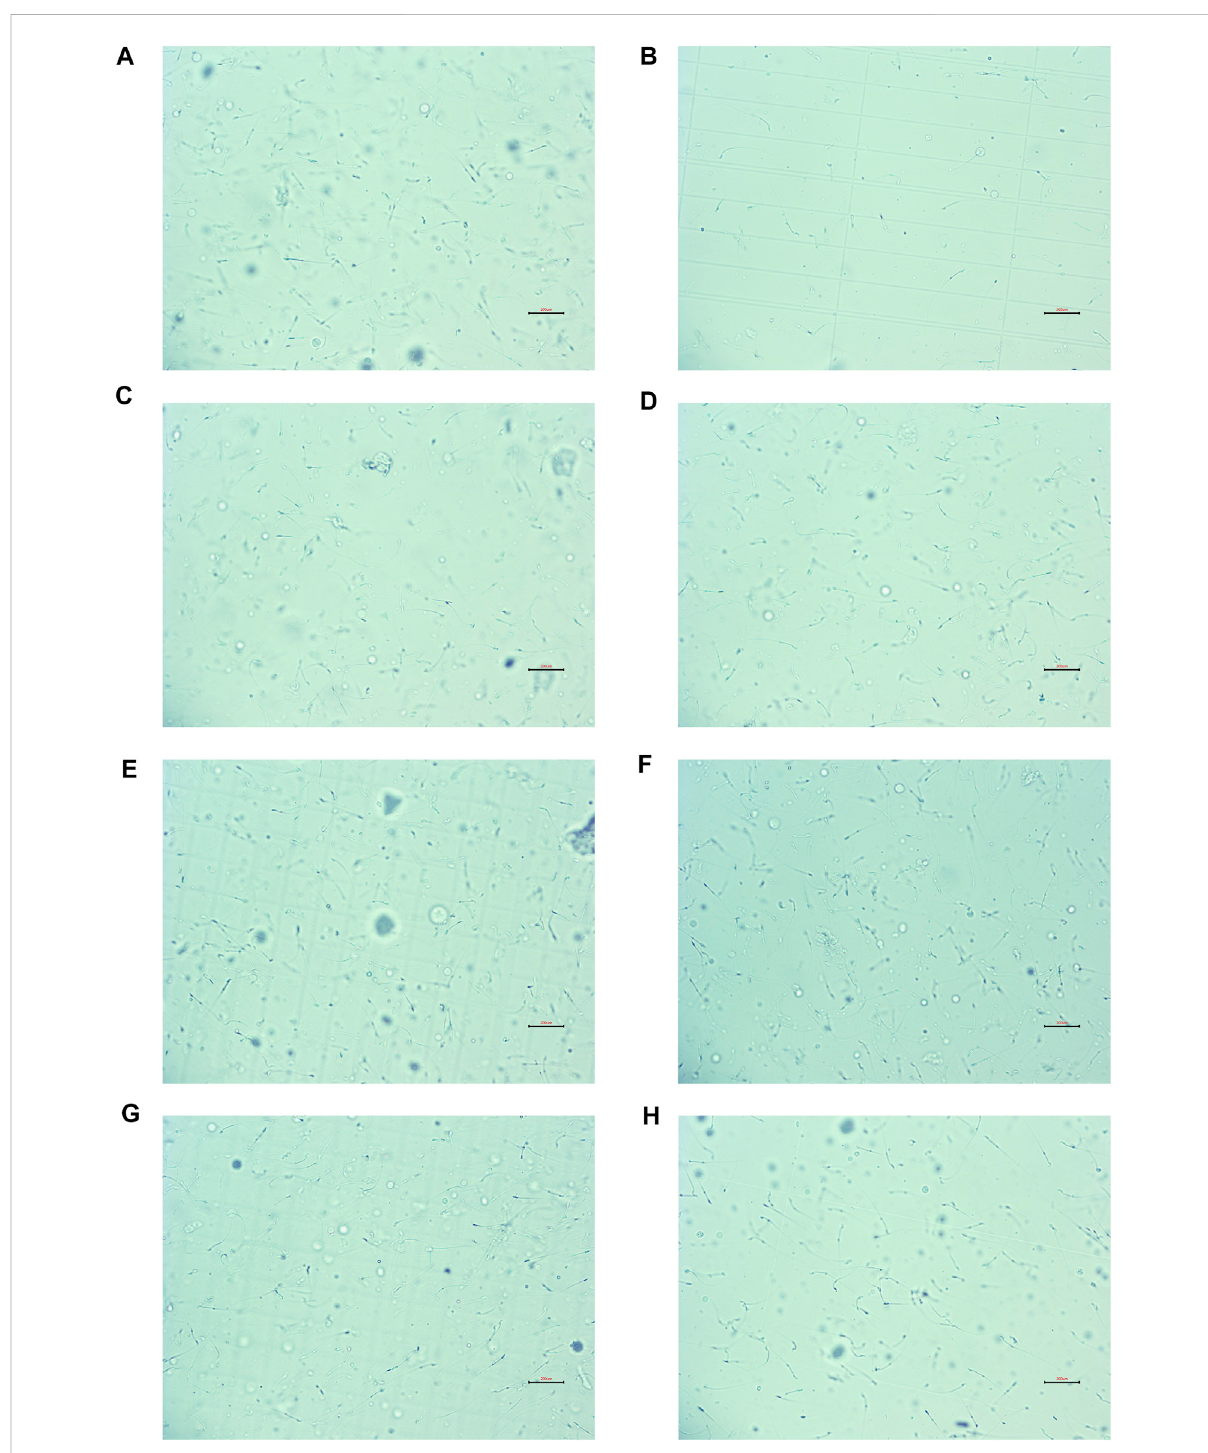
FIGURE 11 The sperm morphology (×200). (A) The normal control group. (B) The model control group. (C) The kaempferol group. (D) The quercetin group. (E) The isorhamnetin group. (F) The beta-sitosterol group. (G) The low-dose CCMM group. (H) The high-dose CCMM group. Data: n = 8, experiments performed in